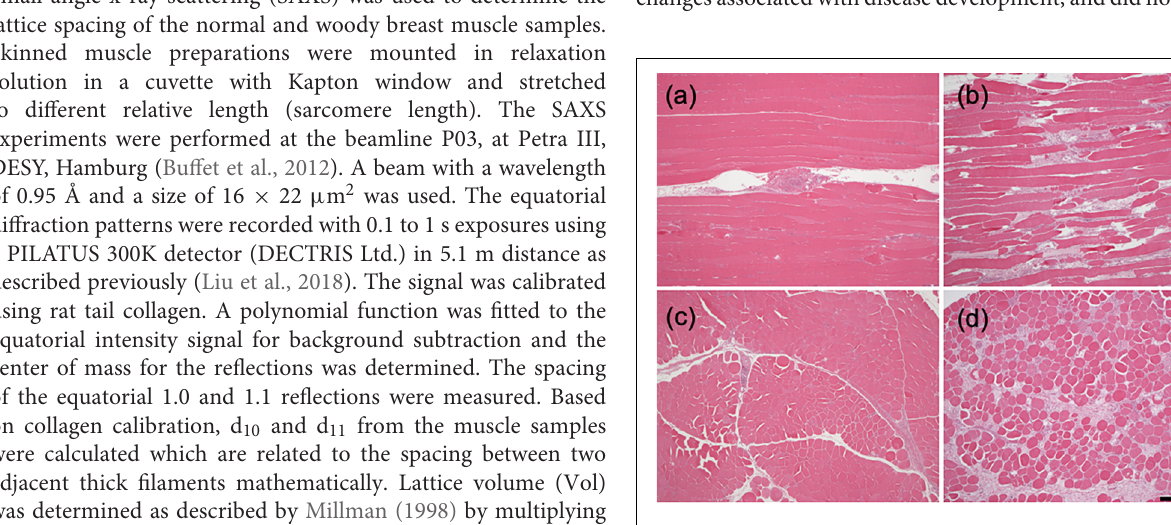
FIGURE 1 | Histology of woody and normal breast muscle. Longitudinal (a,b) and cross-sections (c,d) of clinically normal pectoralis major muscle (a,c) woody breast (b,d) muscles (bar = 0.5